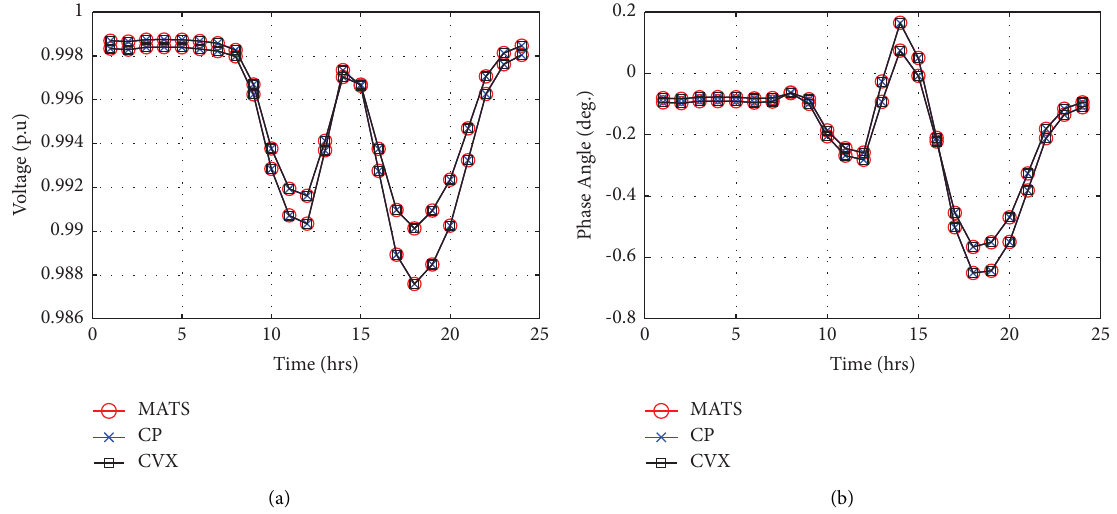
Figure 4: Voltage magnitude (a) and phase (b) plot for simulation 3E.